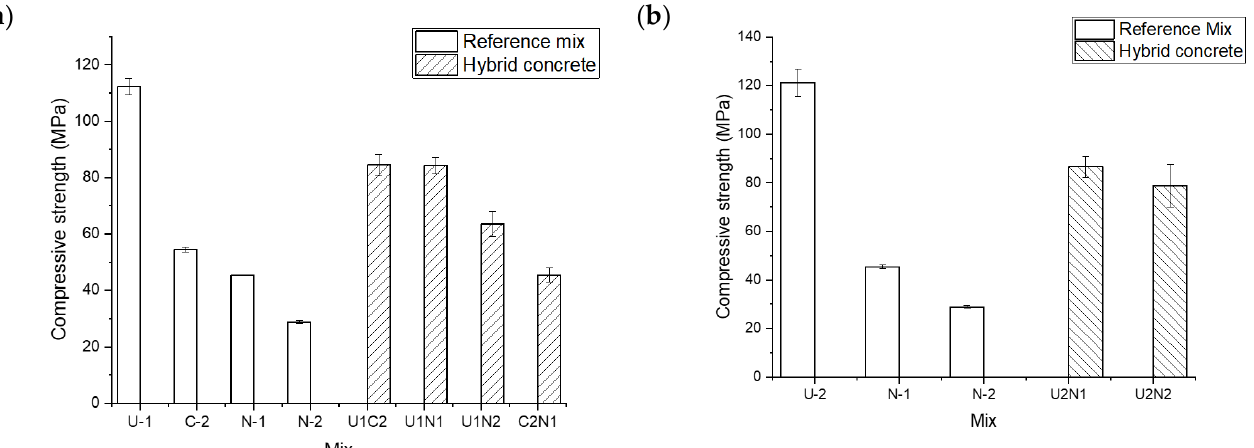
Figure 14. The 28-day compressive strength of hybrid concretes; ( a ) in combination with UHPC (U1) ( b ) in combination with UHPC containing steel fibers (U2) .